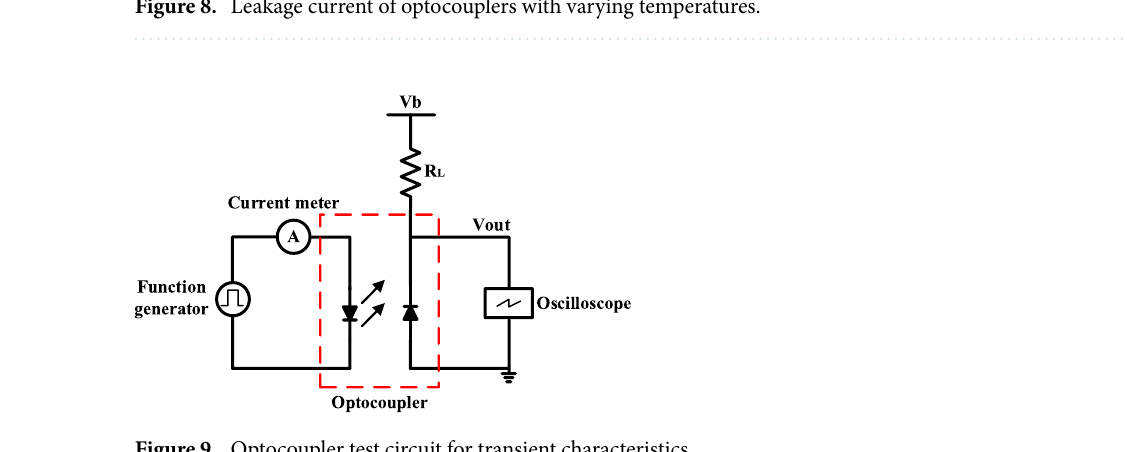
Figure 9. Optocoupler test circuit for transient characteristics.